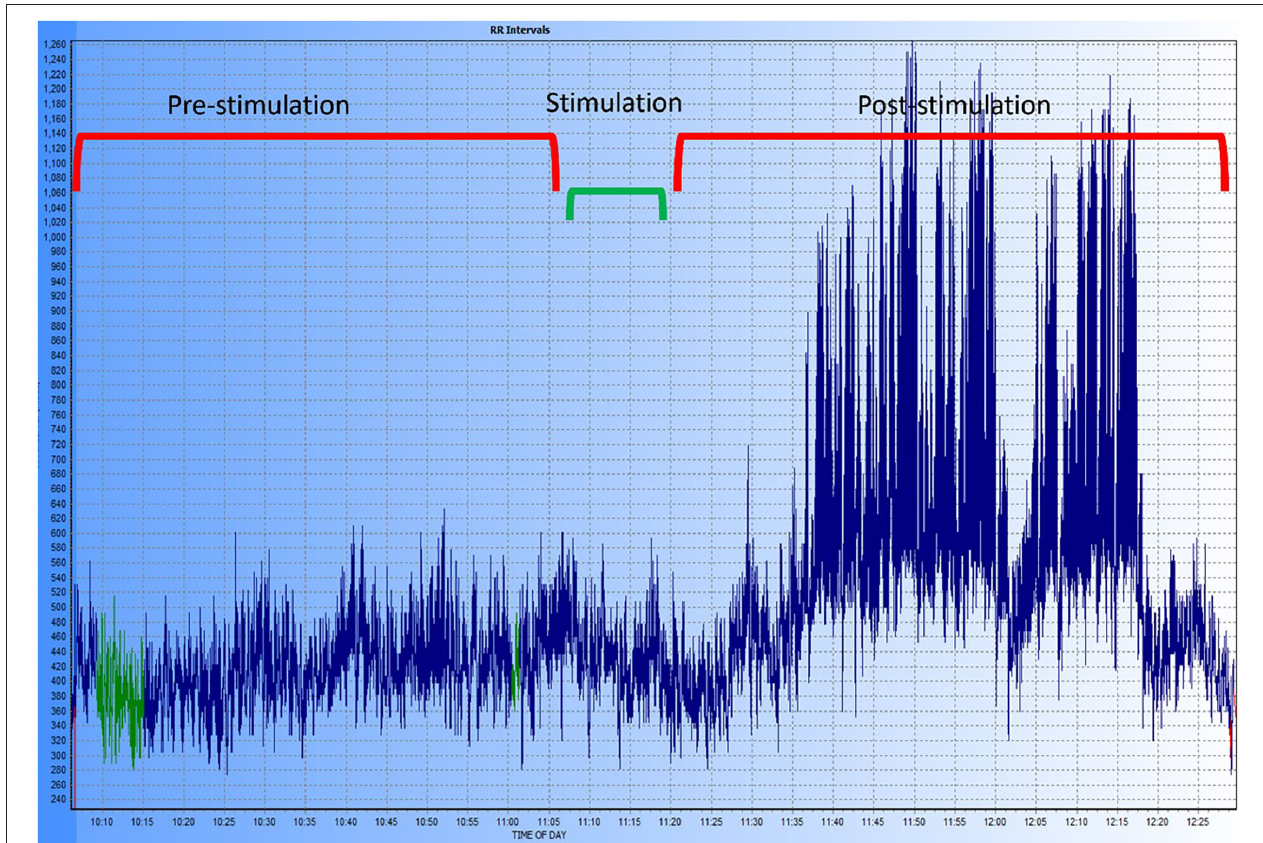
FIGURE 10 | Exemplary tachogram representing the R-R intervals in one of the dogs of the study. The different time periods are shown at the top of the graphic, the period labeled “stimulation” includes the 5-min pre- and post-stimulation margin used for the HRV analysis. A marked increase in HRV can be observed after stimulation and during the entire post-stimulation period